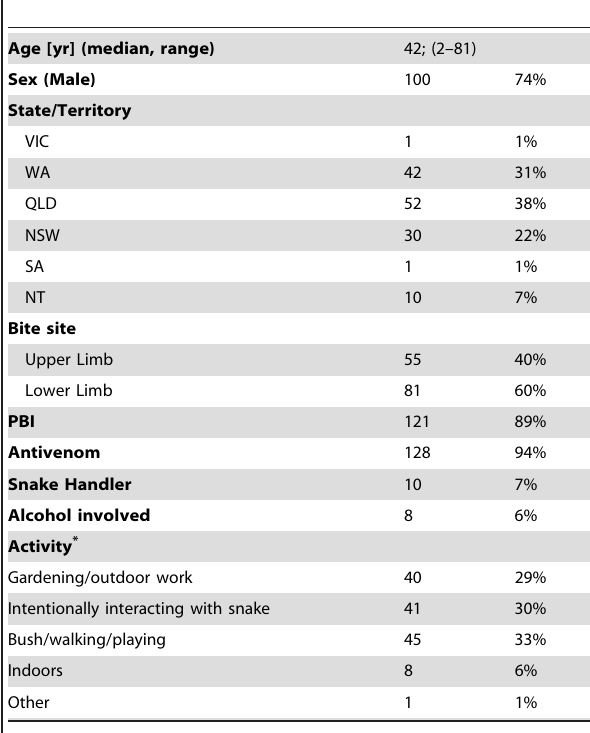
Table 1. Demographic features of 136 definite brown snake envenoming